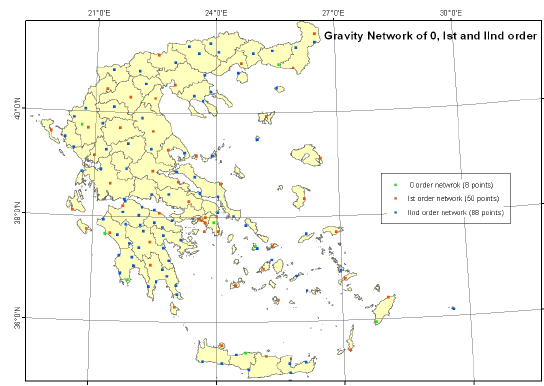
Figure 2: HMGS gravity